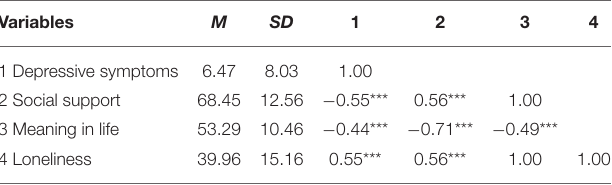
TABLE 2 | Bivariate correlations between variables of interest.